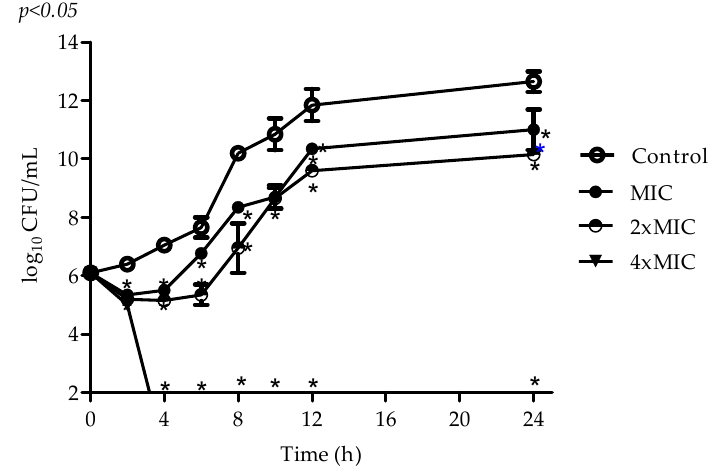
Figure 2. Effects of VIO on the viability of S. aureus ATCC 6538P . VIO (MIC = 1.25 μ g/mL); Control: without VIO. Detection limit was 10 2 colony forming units per milliliter (CFU/mL) and the assays were performed in triplicate. Data are expressed as mean ±SEM of three experiments. * p < 0.05 compared with the control.